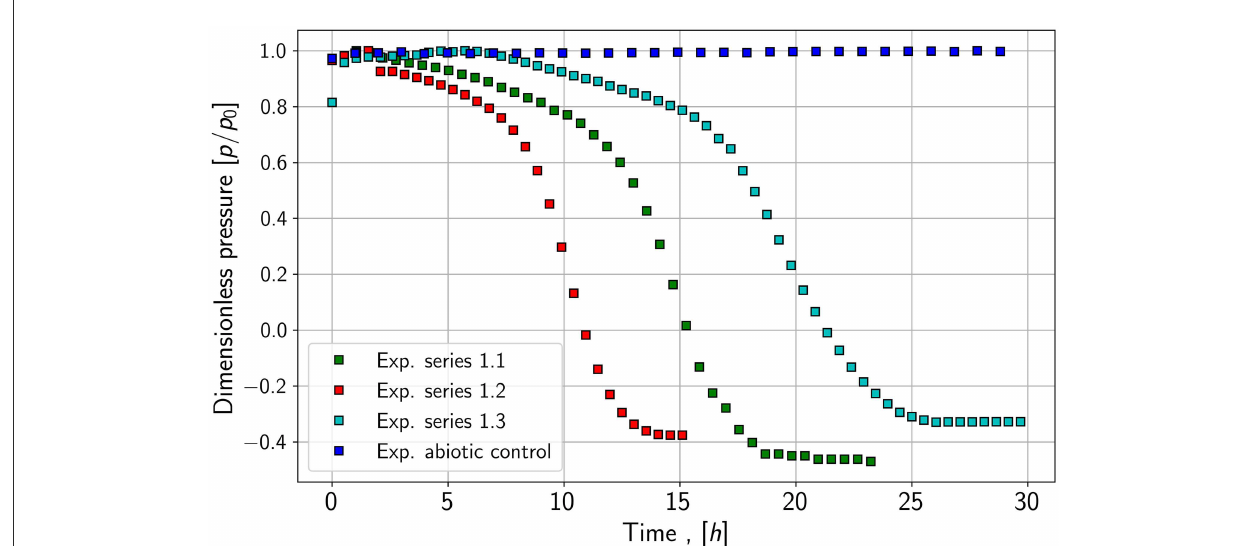
FIGURE2 Pressure drop in the gas phase of the reactor for species 1 and a abiotic control.